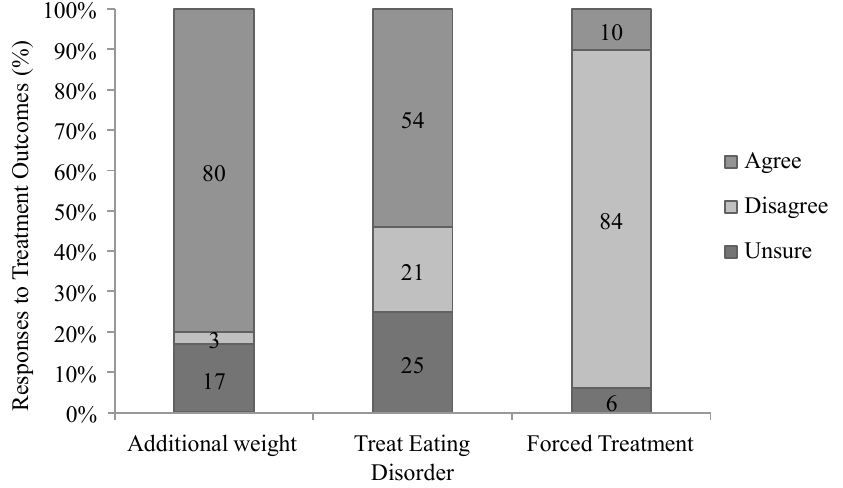
Figure 2. Attitudes toward obesity treatment based on the